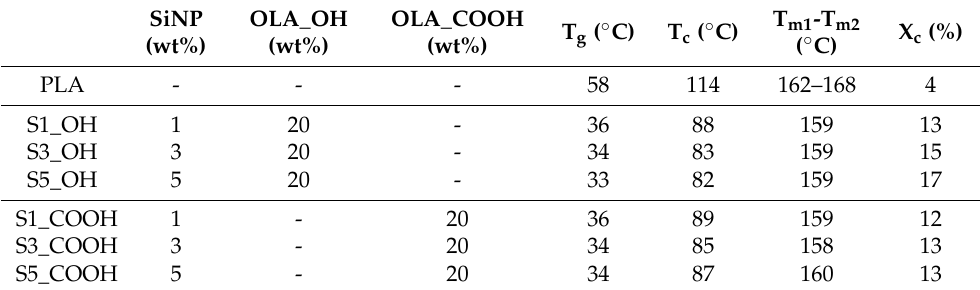
Table 2. Composition of nanocomposites and calorimetric (DSC) parameters: glass transition temper- ature (T g ), cold crystallization temperature (T c ), melting temperature (T m ), and crystallinity content (X c ). Estimated errors are ± 1 ◦ C for temperatures and ± 2% for crystallinity content.